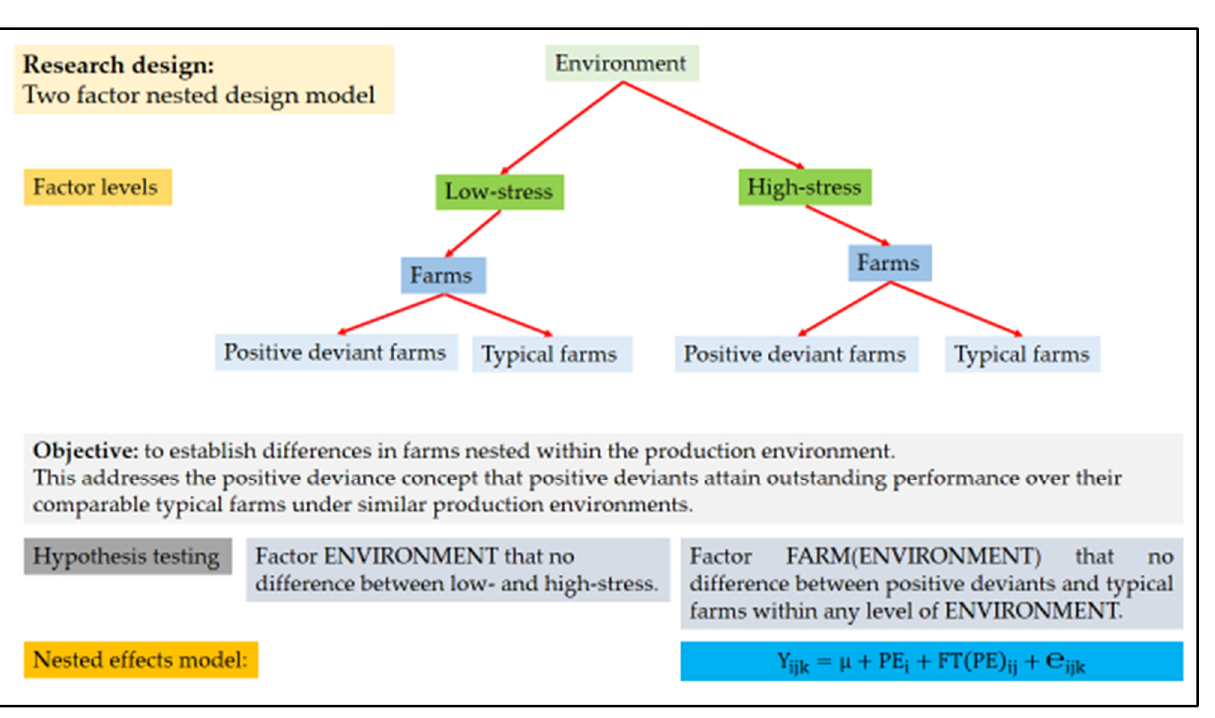
Figure 1. Schematic representation of a two factor nested research design model.